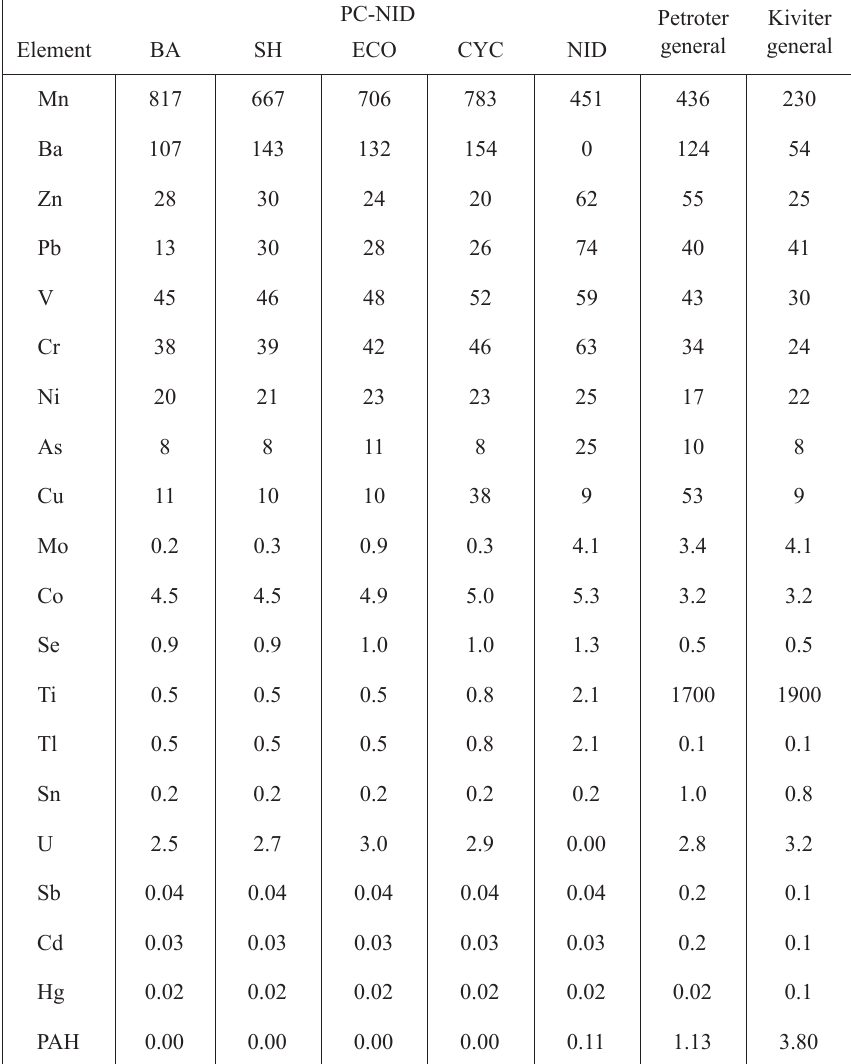
Table 4. Trace element composition of PC-NID plant, Petroter and Kiviter oil shale ash samples, ppm PC-NID Petroter general